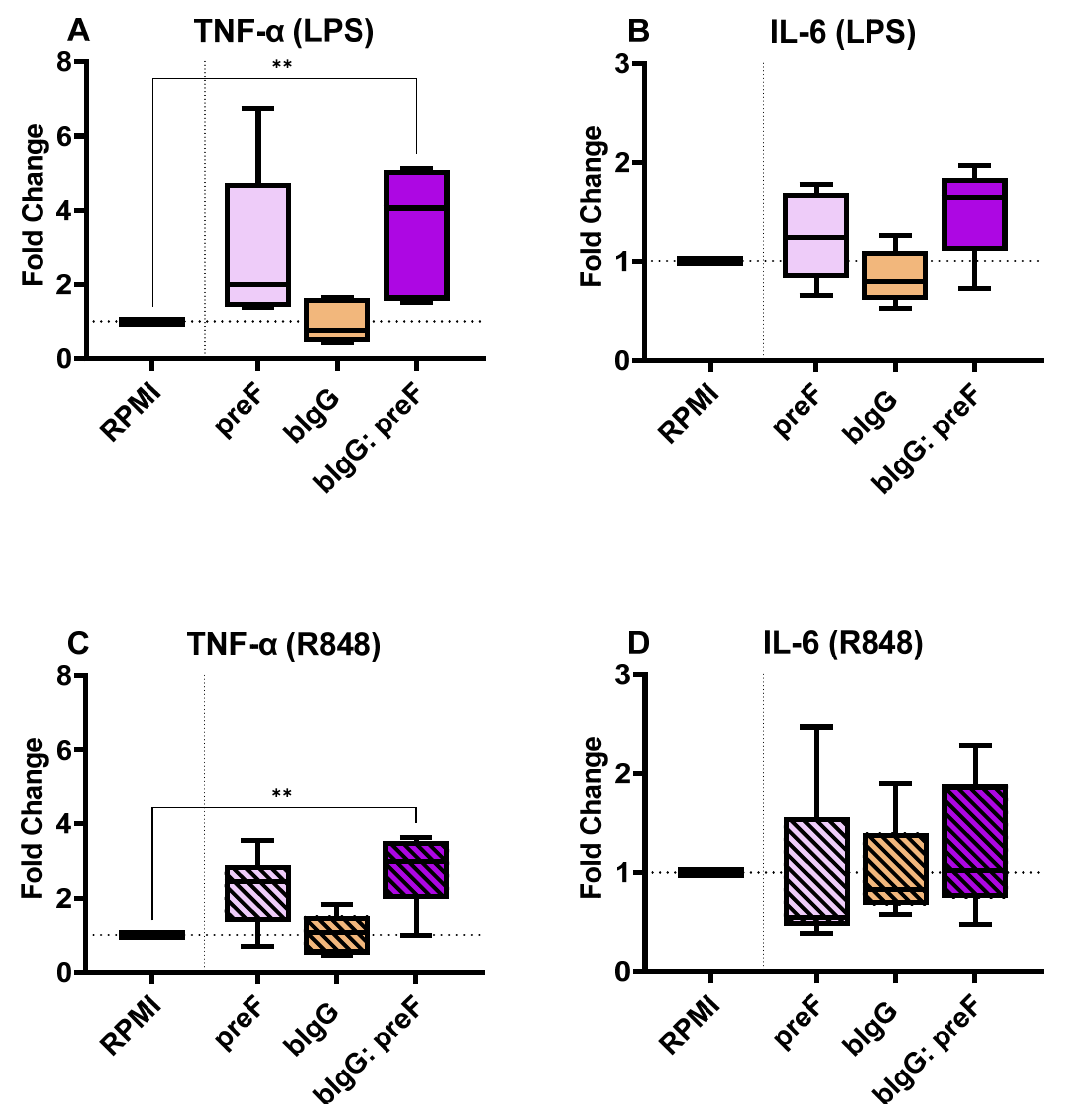
Figure 5. The fold changes in the TNF- α ( A ) and IL-6 ( B ) production in the cells trained with preF only (50 µ g/mL) bIgG alone (10 µ g/mL), or bIgG: preF ICs compared to untrained monocytes (RPMI) upon stimulation with LPS. Also, the TNF- α ( C ) and IL-6 ( D ) production fold changes compared to the RPMI control in the group of monocytes trained with single components or the bIgG: preF ICs after stimulation with and R848. The average (range) of cytokines in the RPMI controls of all 8 donors tested were 1791 (719–4825 pg/mL), 3522 (1044–7232 pg/mL), 3181 (1839–7434 pg/mL), and 9840 (3732–14,230 pg/mL) for conditions A to D, respectively. The boxes represent 50% of the data, and the line is the median value where upper and lower whiskers present the upper and lower 25% of the data, respectively. The significance of differences is shown as p -value < 0.01